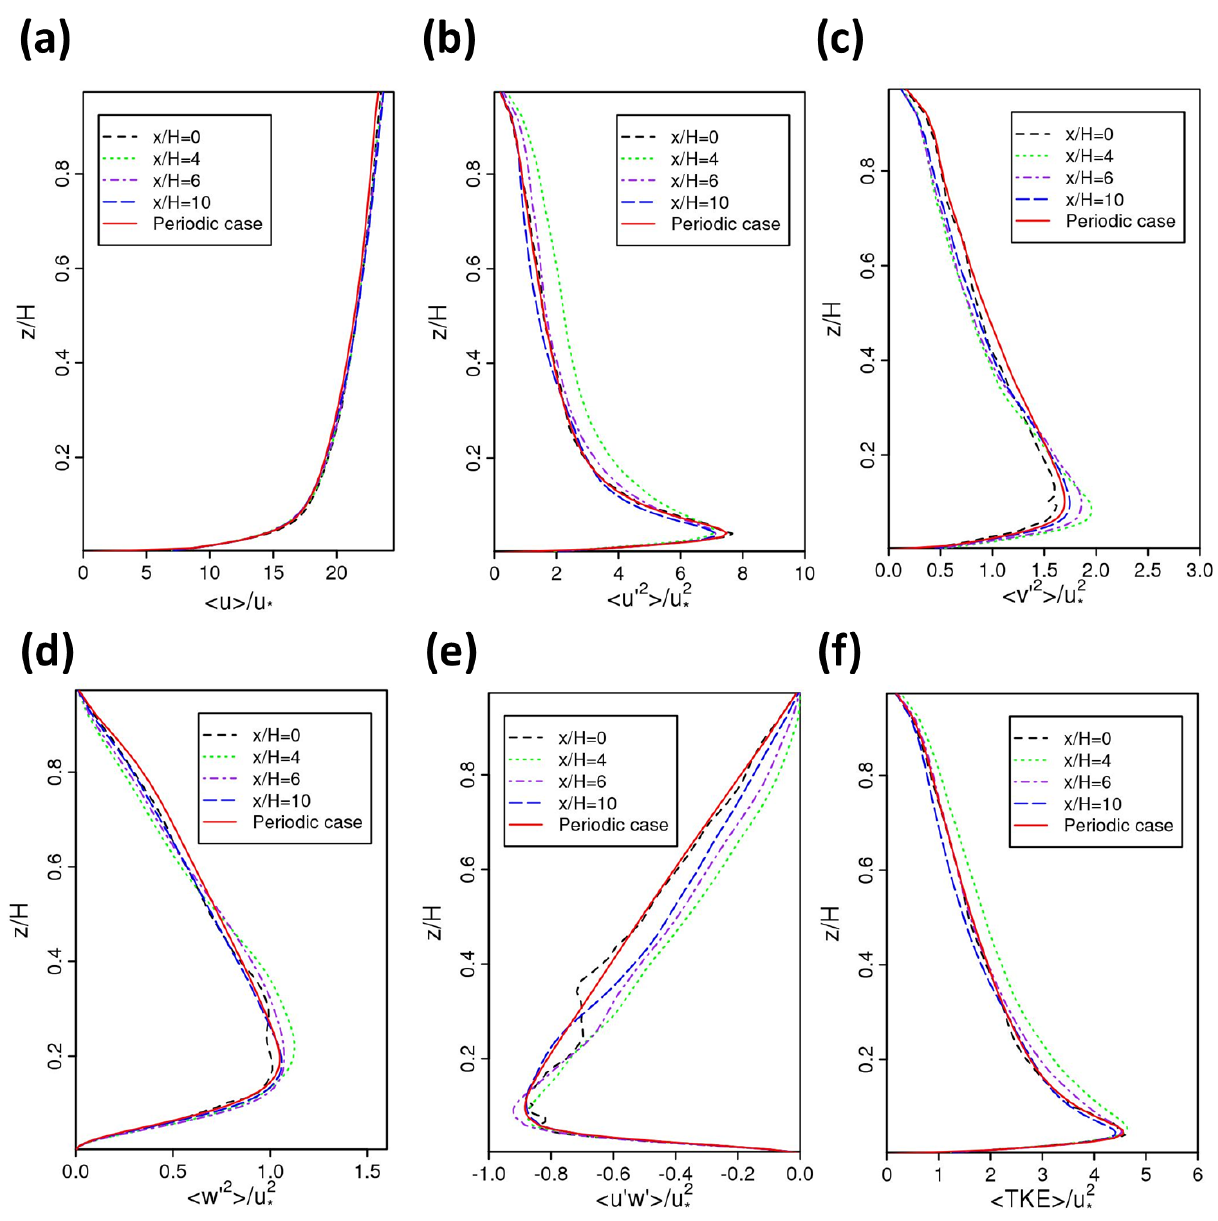
Figure 5. Spatially and temporally averaged vertical profiles of (a) (cid:104) u (cid:105) /u ∗ , (b) (cid:104) u (cid:48) 2 (cid:105) /u 2 ∗ , (c) (cid:104) v (cid:48) 2 (cid:105) /u 2 ∗ , (d) (cid:104) w (cid:48) 2 (cid:105) /u 2 ∗ , (e) (cid:104) u (cid:48) w (cid:48) (cid:105) /u 2 ∗ , and (f) (cid:104) TKE (cid:105) /u 2 ∗ at a series of downwind locations in the inflow case (LS1.0), and the periodic case (also averaged in the streamwise